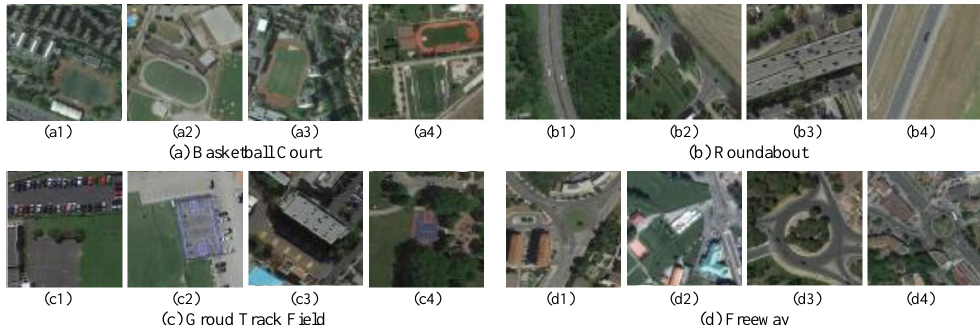
Figure 1. Schematic diagram of some samples with complex backgrounds in the NWPU-RESISC45